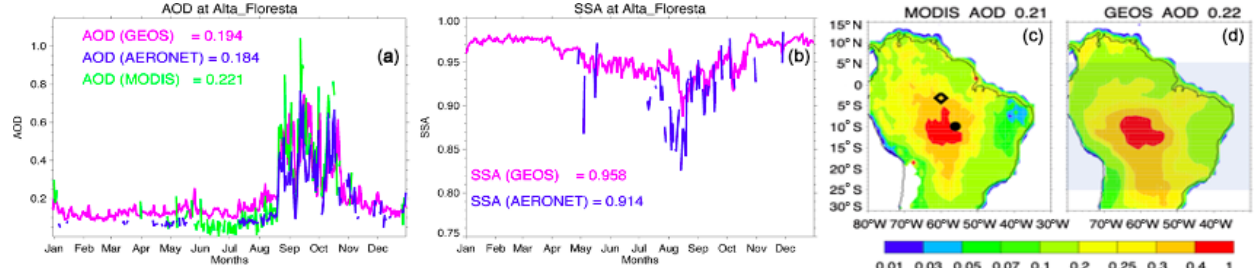
Figure 2. (a) Comparison of GEOS simulated AOD at 550nm with AERONET and MODIS daily measurements at the Alta Floresta AERONET site for 2014. (b) Similar comparison for aerosol single-scattering albedo at 440nm during 2014. (c) Mean MODIS collection 6.1 AOD at 550nm during the period August–October 2014. (d) GEOS simulated AOD at 550nm for the same period as in (c) with daily model data sampled following MODIS measurements. Note that the mean AOD values shown for (c, d) are averaged over the Amazon region (i.e., the shaded land area within 25 ◦ S–5 ◦ N, 80–30 ◦ W shown in d ). Station locations of Alta Floresta (filled-circle) and Manaus (open diamond) are marked in (c)